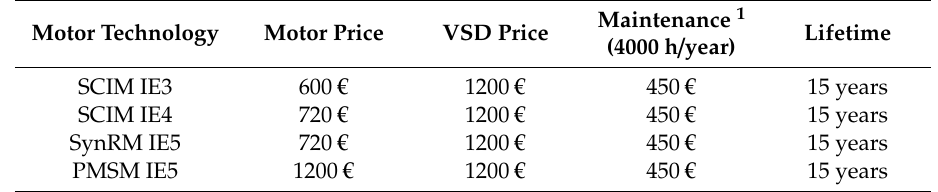
Table 5. Assumptions for the calculation of the life-cycle cost of the four analyzed motor technologies.